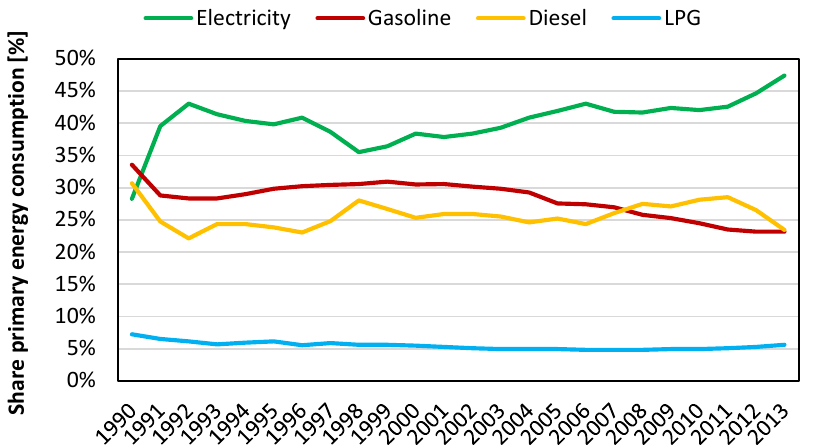
Figure A1. Share of energy carriers in primary energy consumption [87].